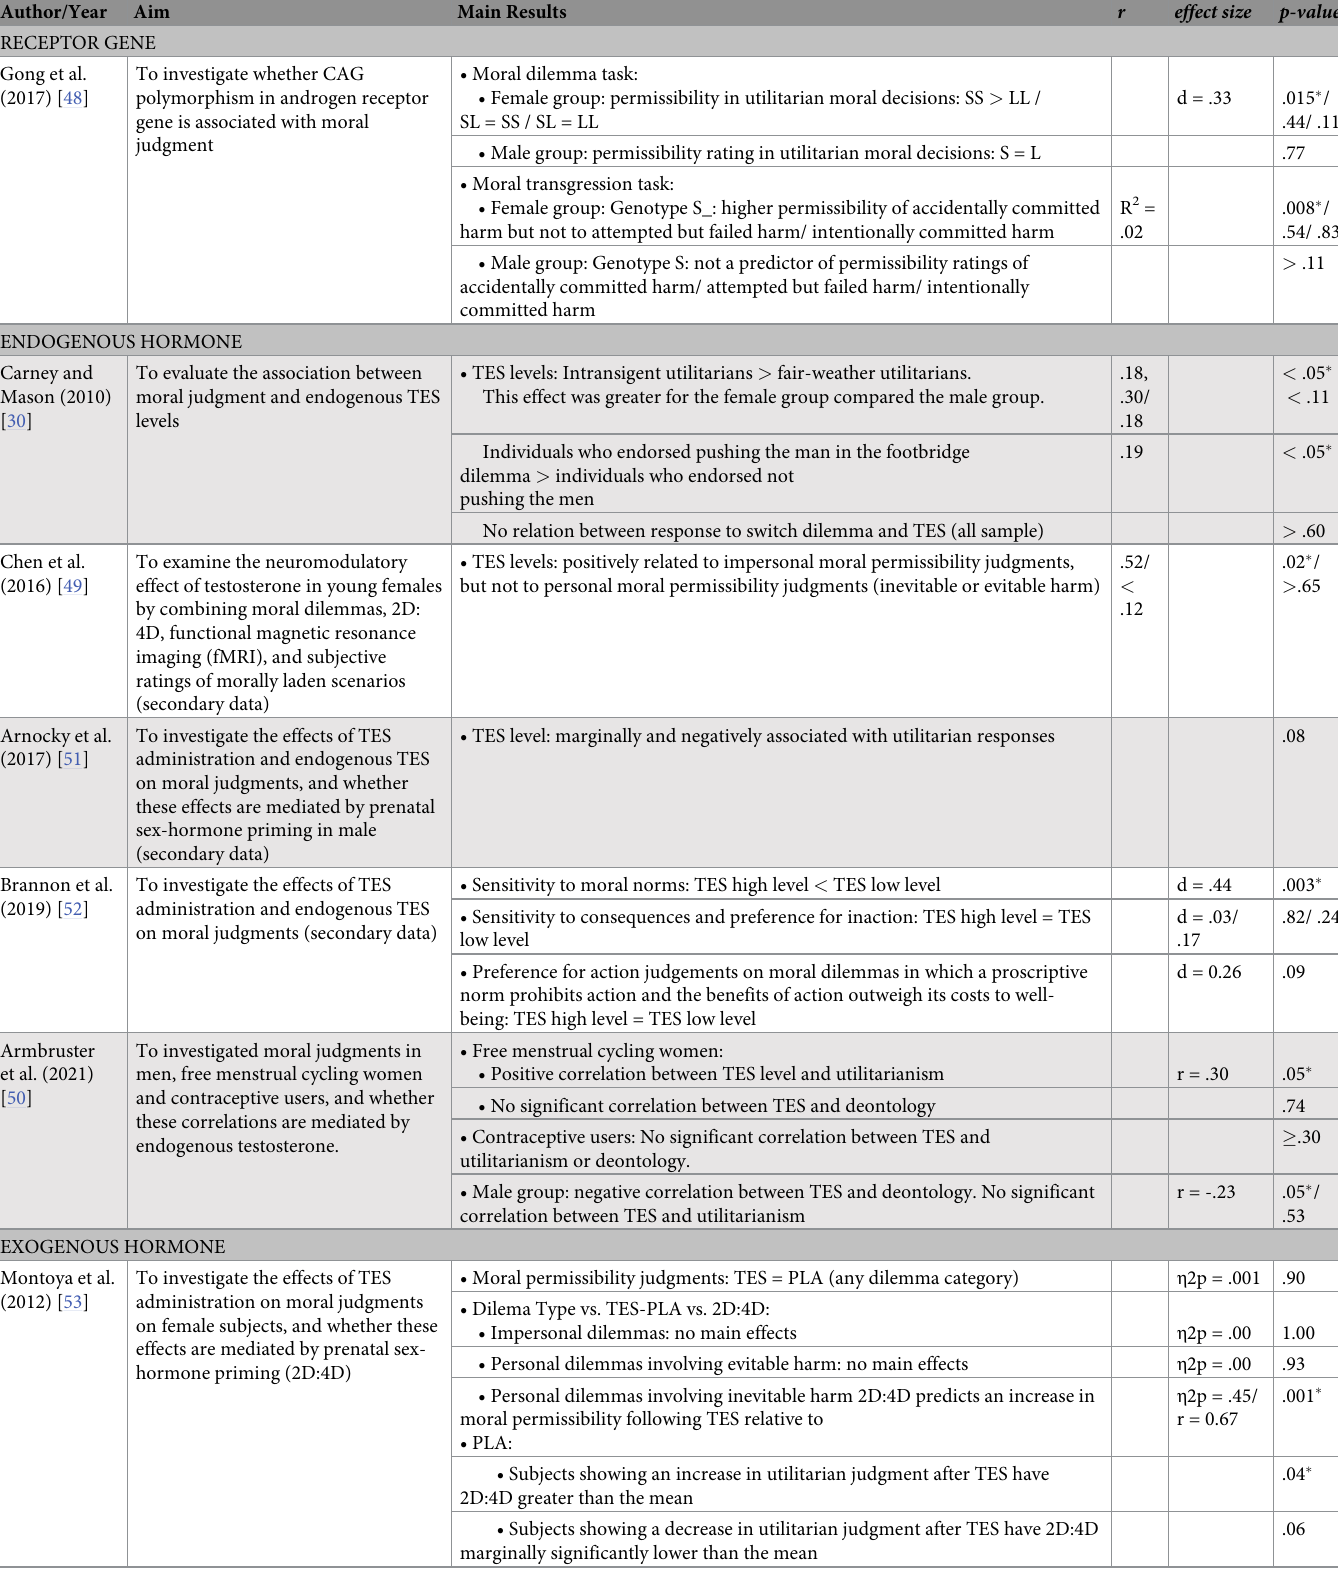
Table 4. Main results of the studies on testosterone included in this